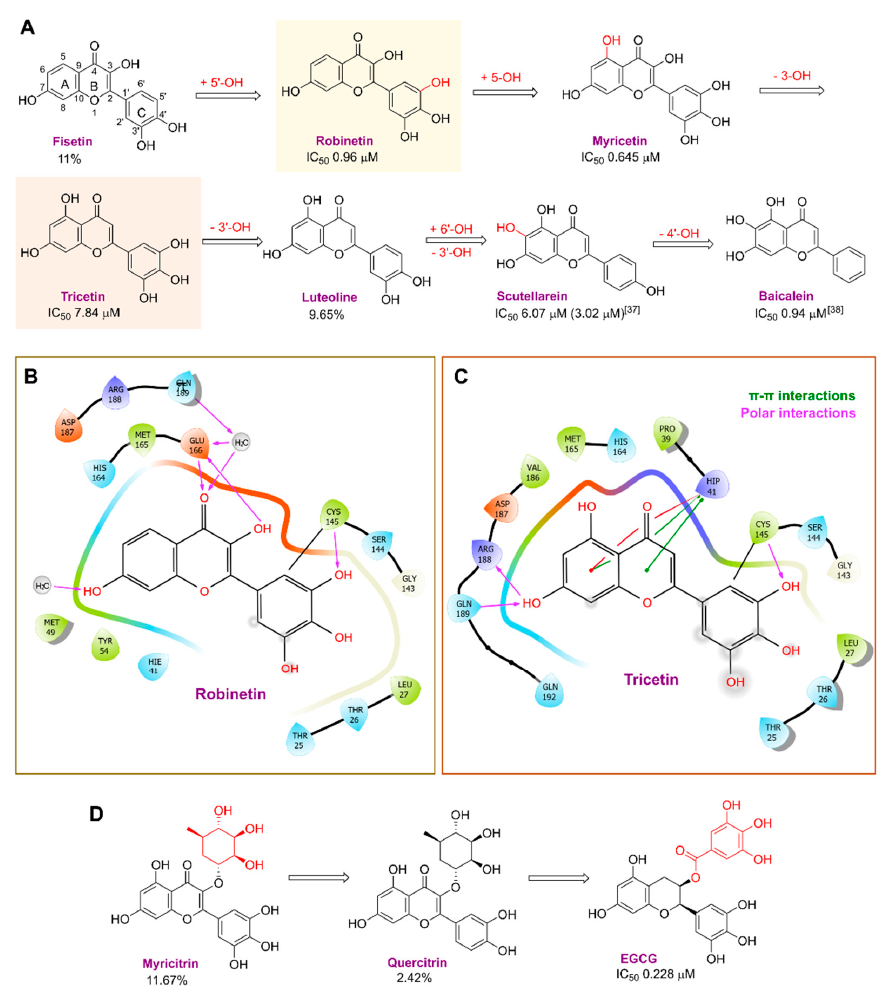
Figure 5. The structure–activity relationships of polyphenolic compounds. The introduction of 5 ′ - OH (Robinetin) and 5-OH (Myricetin) ( A ); an exemplary binding mode for robinetin derived from the crystal structure ( B ); and the docking model for tricetin ( C ); as well as 2D representations of the polyphenols coupled at the 3 ′ subunit ( D ).